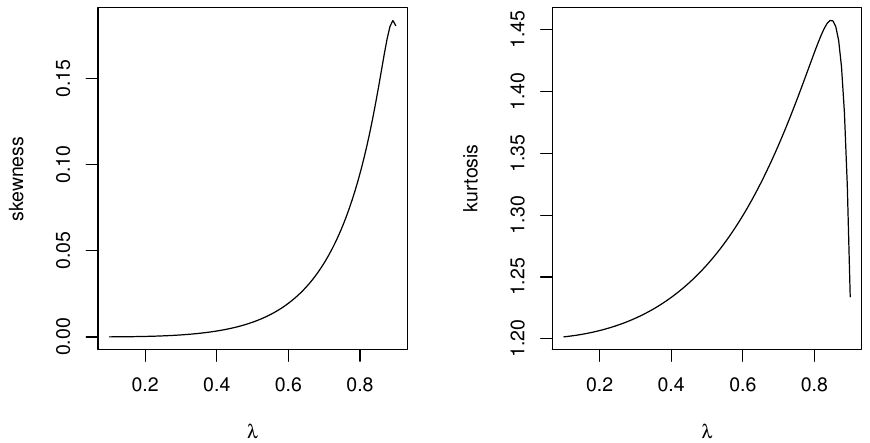
Figure 9. Skewness and kurtosis plots of the LiSL1 distribution as a function of parameter λ